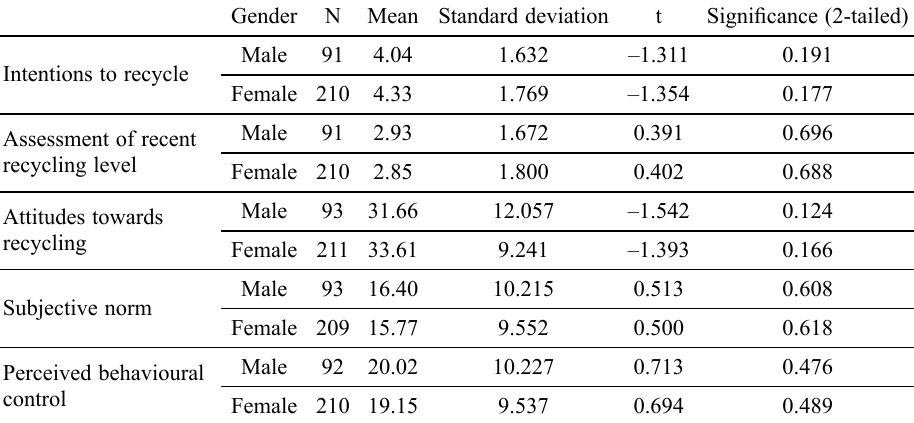
Table 4. Differences in recent recycling level, intentions to recycle, attitudes towards recycling, subjective norm, and PBC among male and female Gender N Mean Standard deviation